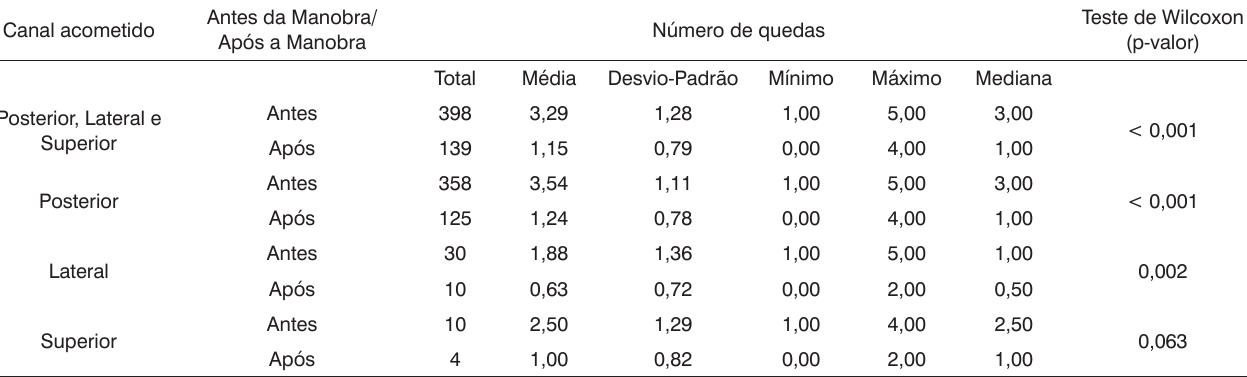
Tabela 2. Número de quedas antes e após o tratamento da Vertigem Posicional Paroxística Benigna em idosos por meio de manobras de reposicionamento de partículas, de acordo com o canal acometido.